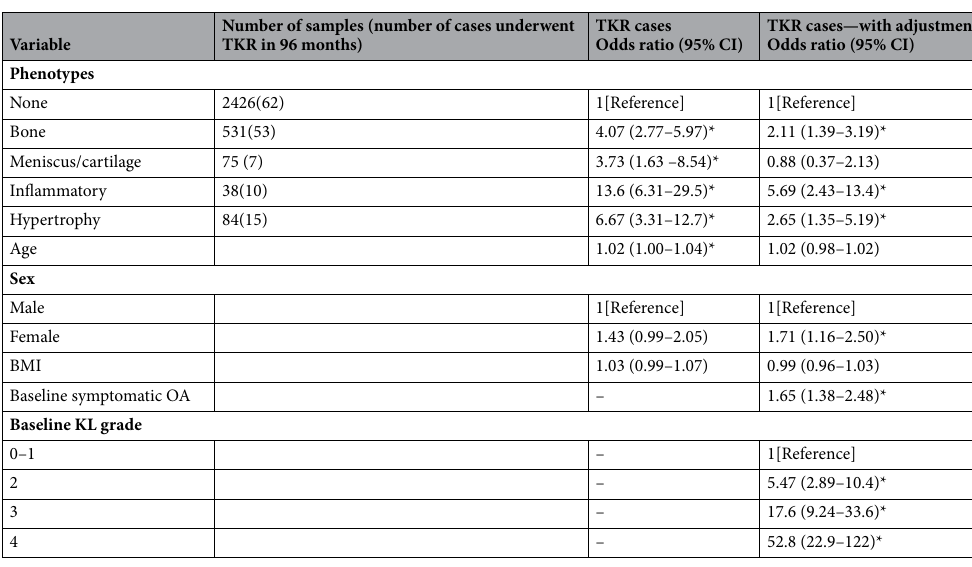
Table 5. Association between phenotypes and undergoing primary TKR, with and without adjustment for symptomatic OA and KL grade, after baseline and prior to the 96-month visit (n = 3154). The adjustment refers to adding baseline symptomatic OA and KL grade as additional predictors in the logistic regression model. Both models adjusted for age, sex, and BMI. “-”, not applicable; OA, Osteoarthritis; CI, confidence interval; BMI, body mass index; TKR, total knee replacement; KL, Kellgren-Lawrence. *Statistically significant at P value <